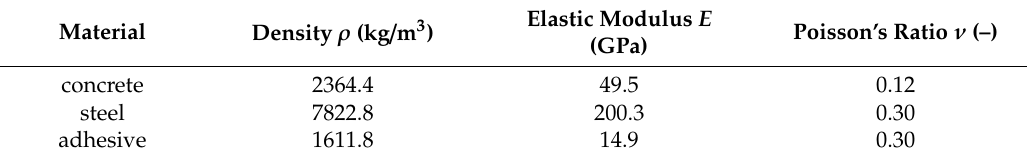
Table 1. Material parameters for each material in numerical